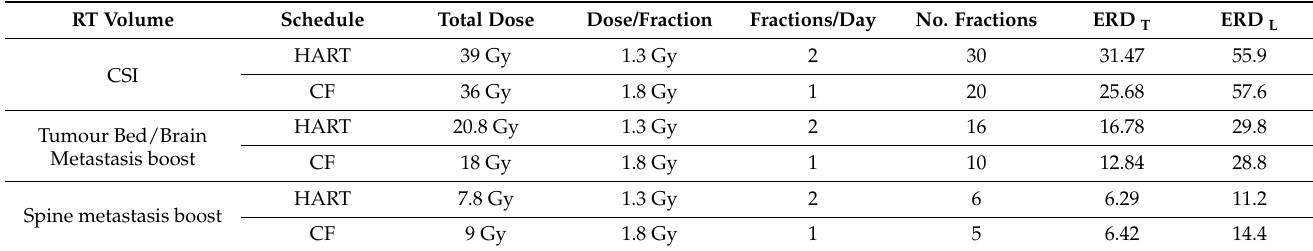
Table 3. Extrapolated response dose for tumour (ERD T) and for late responding tissue (ERD L), according to the Dale equation, comparing HART and conventional fractionation (CF). HART = Hy- perfractionated Accelerated Radiation Therapy; CF = Conventionally Fractionated